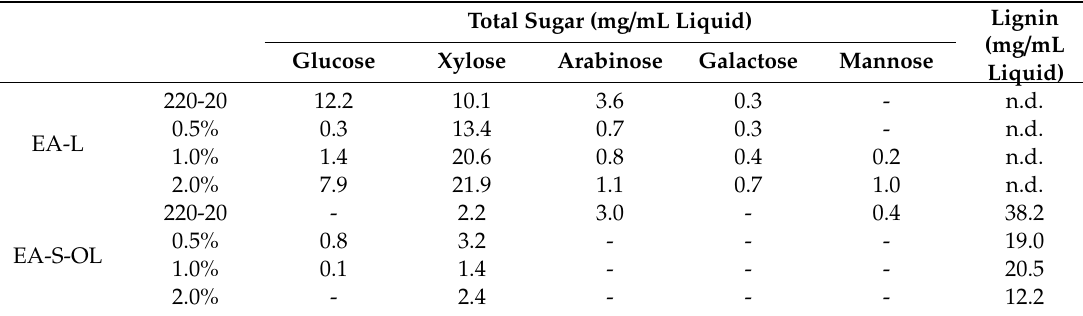
Table 5. Sugar content of acid pretreated EFB liquid